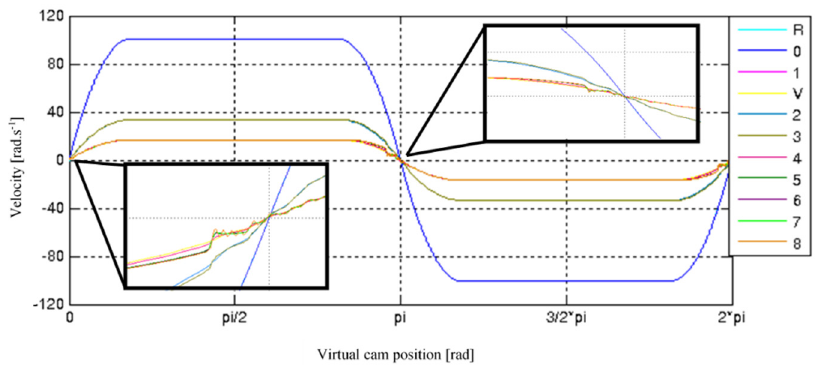
Figure 7. Courses of angular velocities of individual drive system elements.